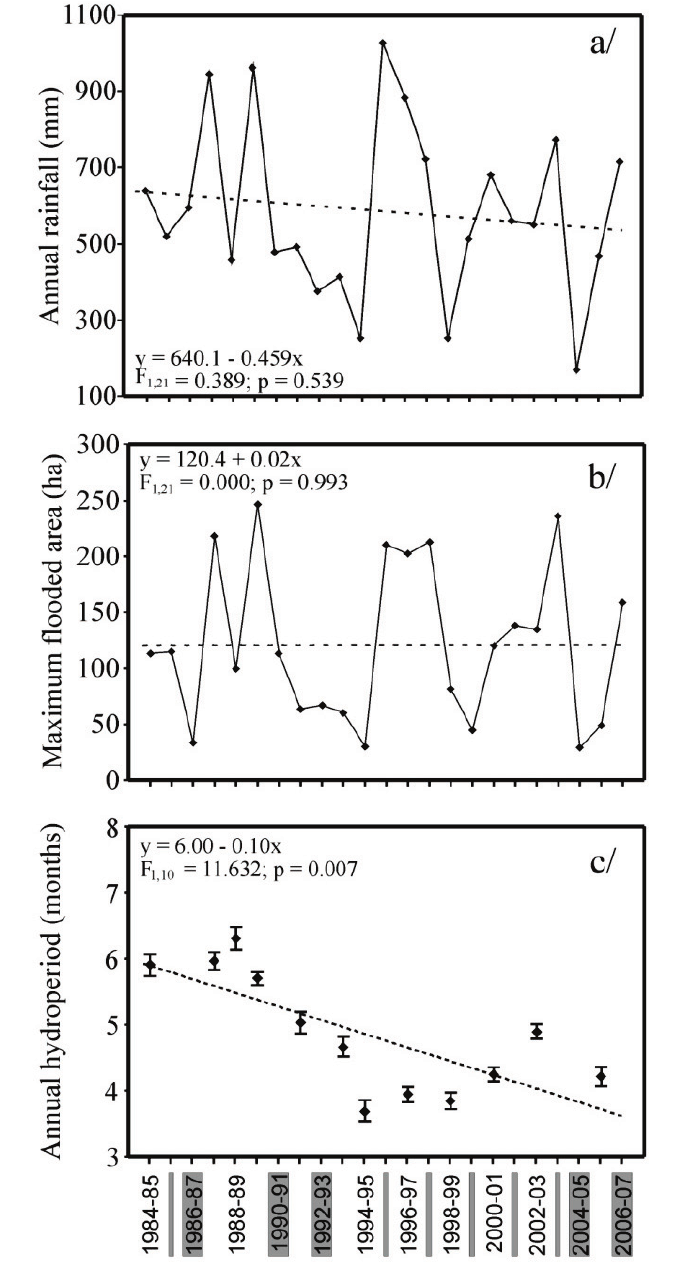
Figure 7. Inter-annual trends in (a) annual rainfall, (b) maximum flooded area and (c) annual hydroperiod (mean and standard error) for the entire study area. Linear fit and adjusted equation is also shown. Years in grey indicate that no representative or enough images were available to compute annual hydroperiod that